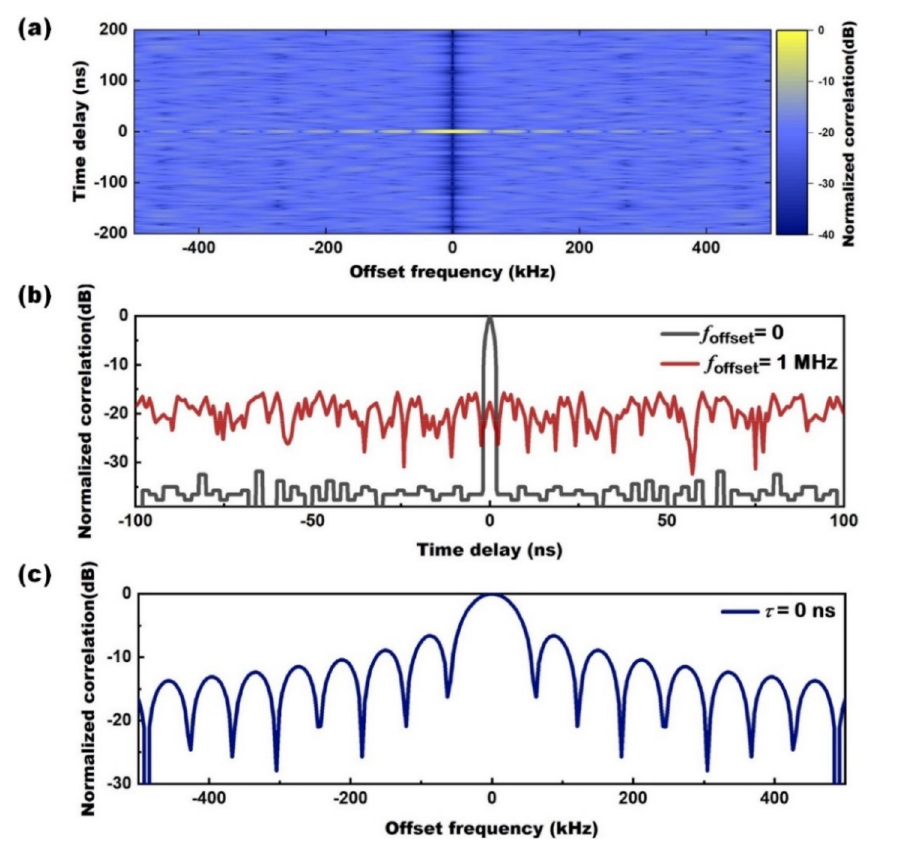
Figure 3. ( a ) Normalized ambiguity function (NAF) of a 12-bit M-sequence as a function of time delay and offset frequency. ( b ) Normalized correlation with 0-Hz and 1-MHz offset frequency. ( c ) Normalized correlation at 0-ns time delay as a function of offset